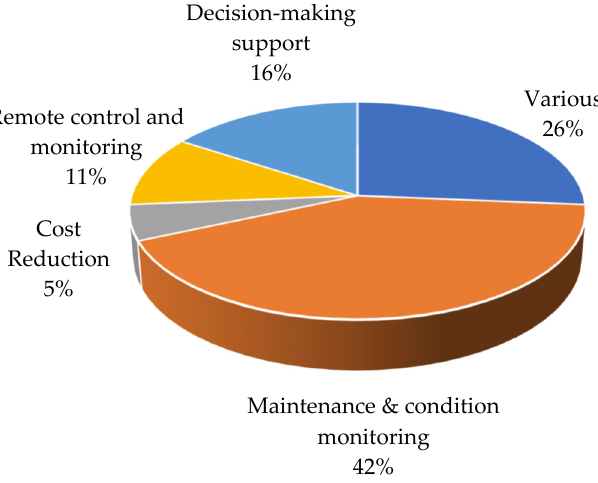
Figure 7. Percentage of the application purposes as presented in reviewed papers.